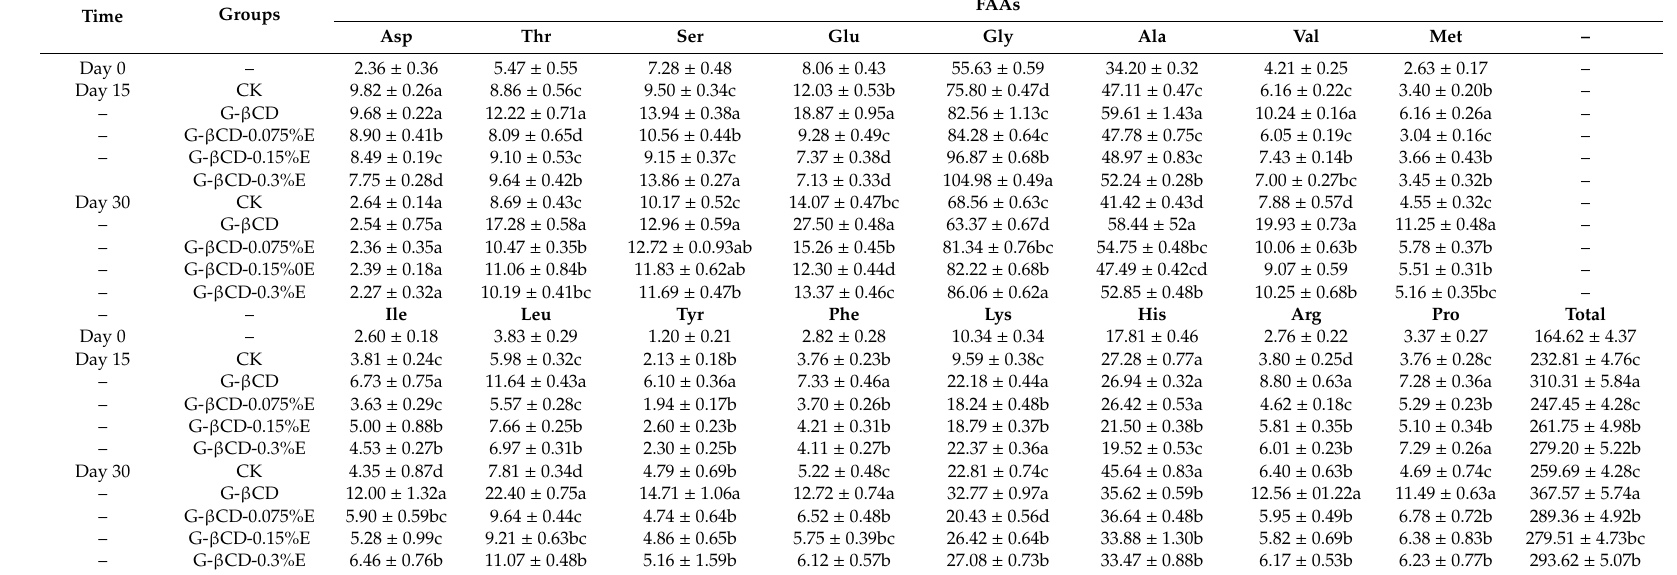
Table 1. Changes in FAAs content (mg / 100 g) in di ff erent treated Chinese seabass samples during superchilling